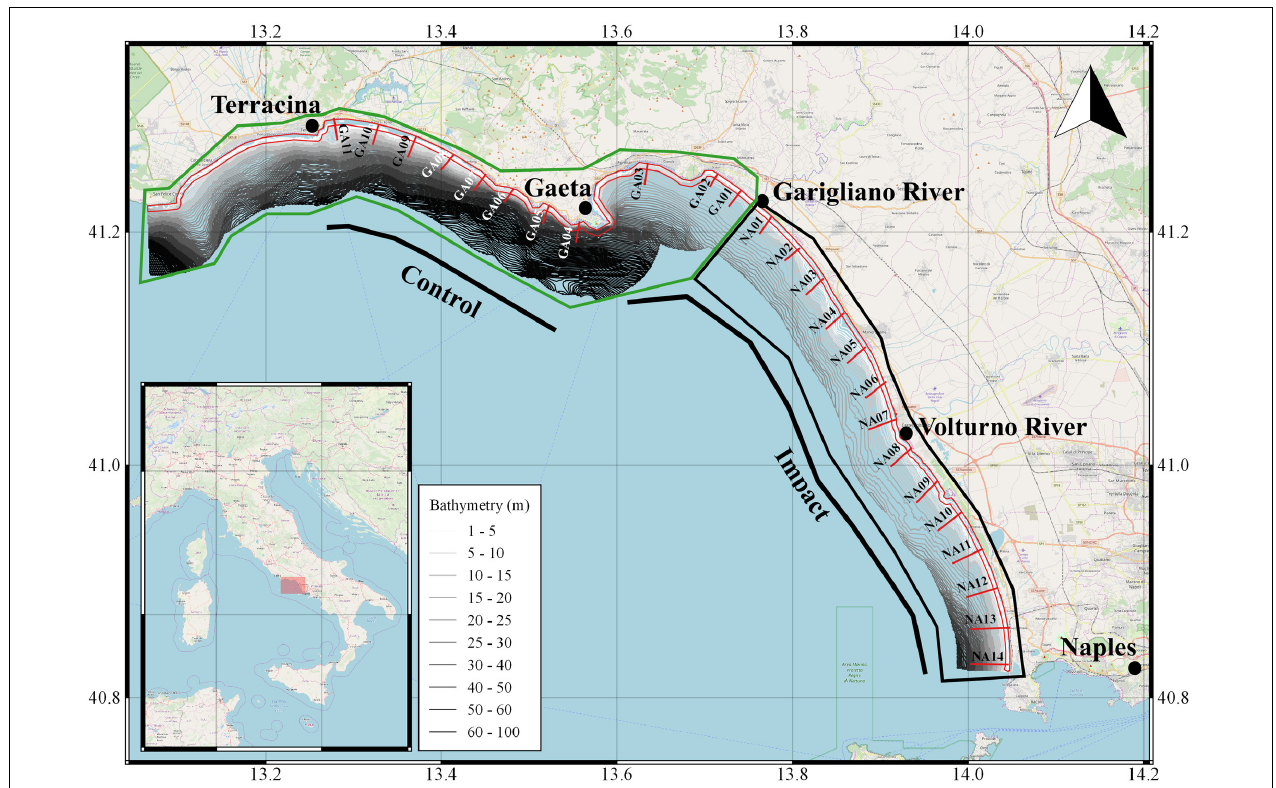
FIGURE 1 | Study area of the dredge.1pc impact surveys. Bars in red represents the transects placed in the two Maritime Compartments of Naples and Gaeta (limited by black and green boxes, respectively). The red polygon represents the 0.3 nm limit within which the surveys were done and that the European Regulation 1967/2006 closed. The bathymetries between the coastline and 4 nm are represented as